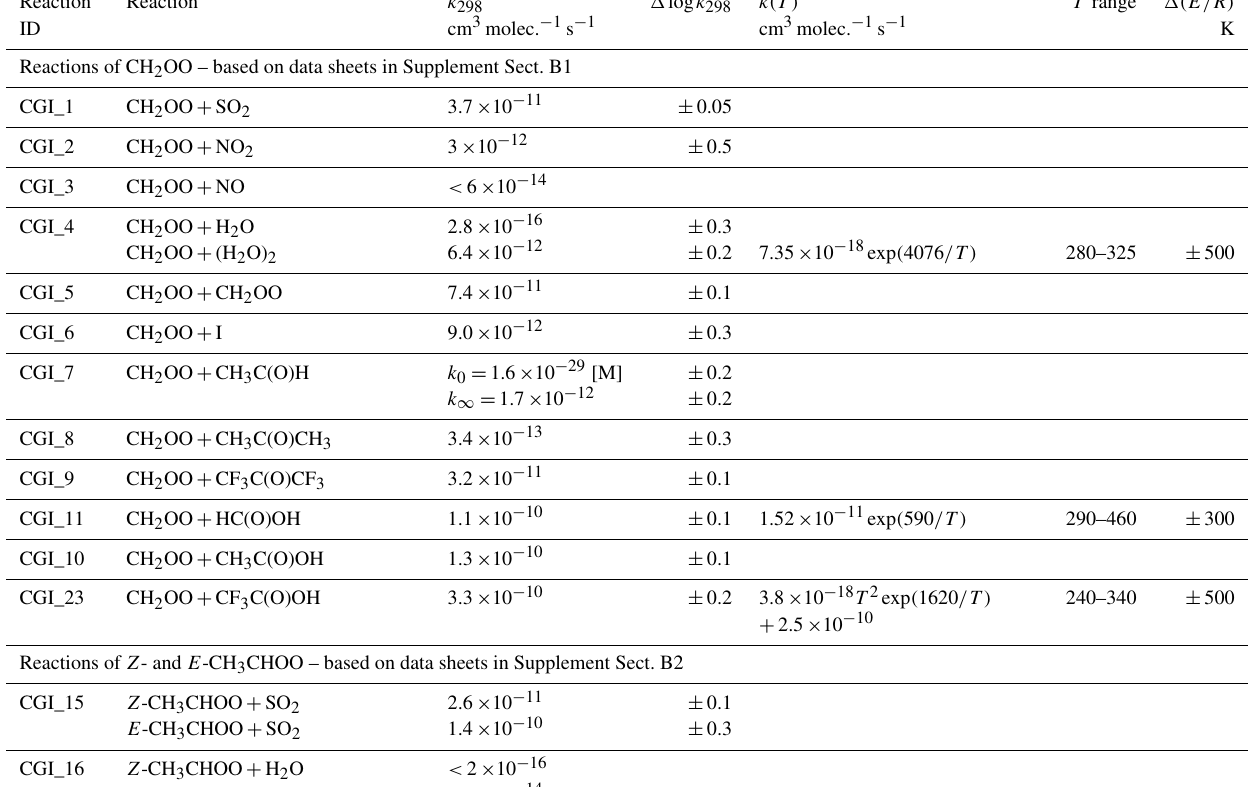
Table 5. Summary of recommended rate coefficients for gas-phase bimolecular reactions of sCIs. Reaction Reaction k 298 (cid:49) log k 298 Reactions of CH 2 OO – based on data sheets in Supplement Sect.